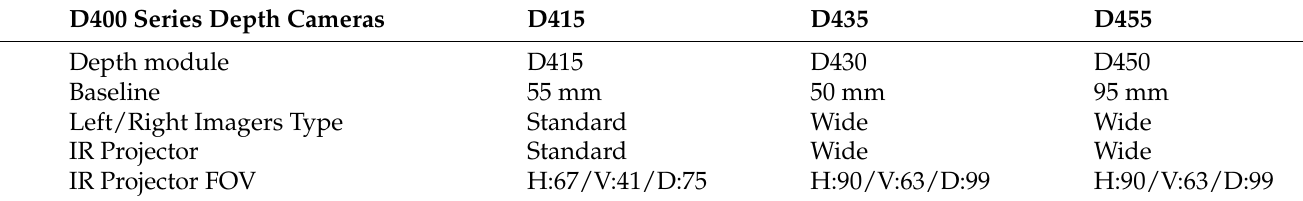
Table 1. Specifications of commercial RGB-D